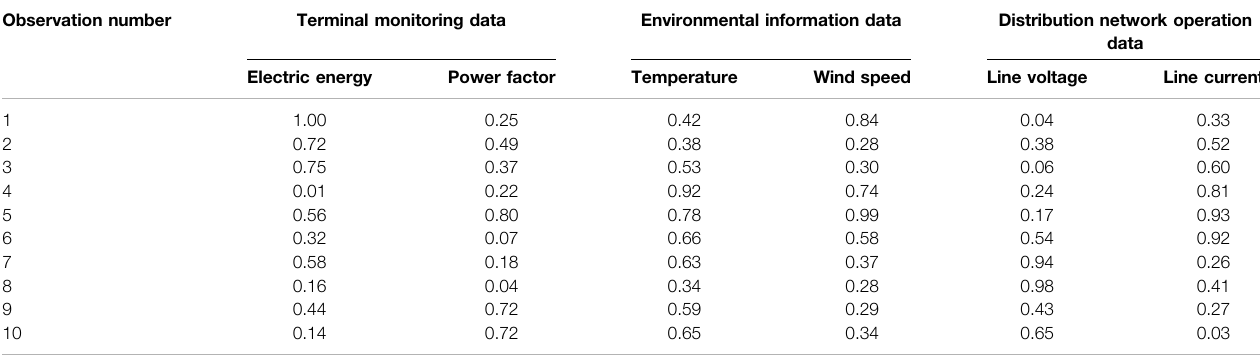
TABLE 1 | BC-Z-score multi-source data processing experimental results values. Observation